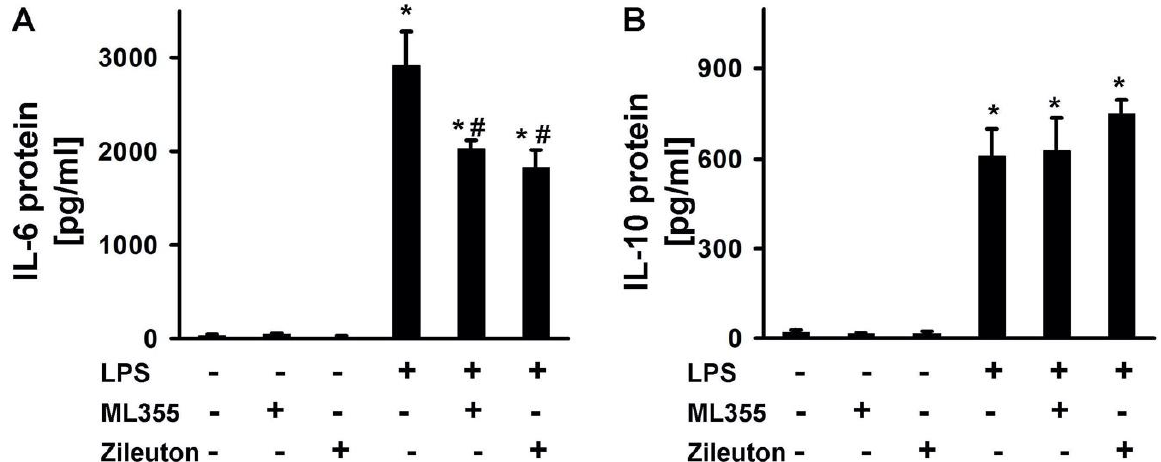
Figure 3. A comparison of ML355 and Zileuton effects on the LPS-induced release of interleukin 6 (IL-6) and interleukin 10 (IL-10) in astrocytes. The primary rat astrocyte cultures were pretreated with Zileuton (10 µ M) or ML355 (10 µ M) for 30 min and then stimulated with LPS (100 ng/mL) for 24 h. The IL-6 ( A ) and IL-10 ( B ) protein release was measured by ELISA in the supernatant samples. The results are expressed as pg/mg. The values represent a mean ± SD from three independent experiments. * p < 0.05, compared with the non-stimulated cells; # p < 0.05, compared with the LPS-stimulated cells.